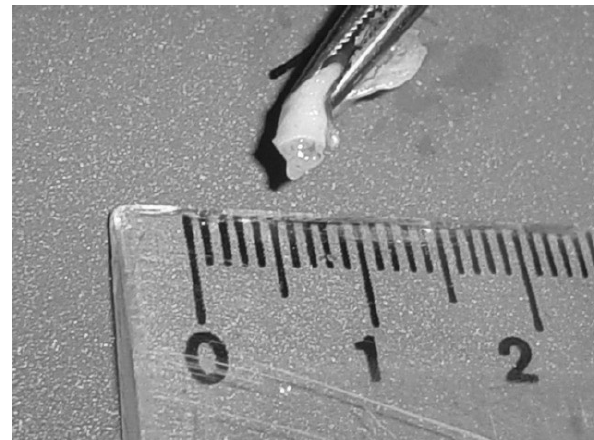
Fig. 6 - Presença de êmbolo de fibrina no interior de uma